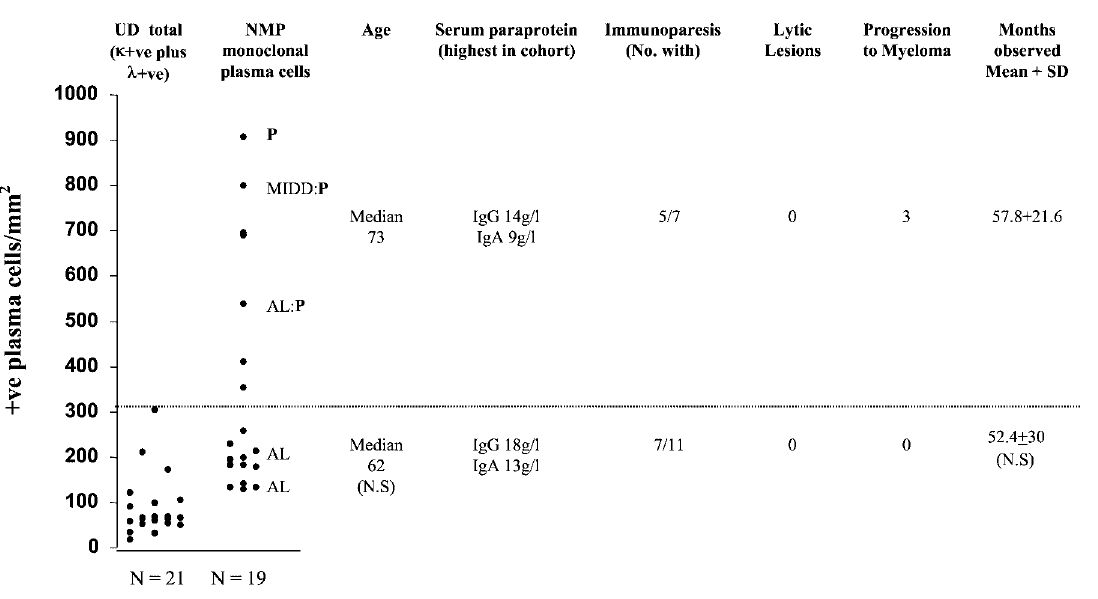
Fig. 1. Findings at presentation and outcome of 19 patients with monoclonal plasma cells above and below 305/mm 2 in bone marrow biopsies from NMP patients. Also shown are total plasma cells ( κ + ve plus λ + ve) in 21 UD patients [4]. P, progression to MM: NS, not